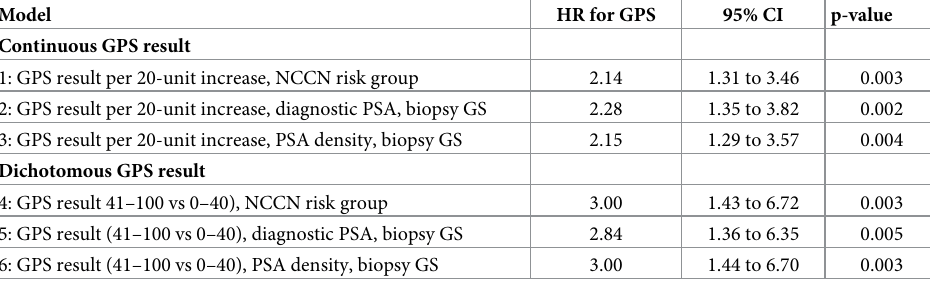
Hazard ratios (HR) for the GPS result and time to post-biopsy BCR in multivariable Cox proportional hazards models, after adjusting for clinical and pathologic covariates (n =